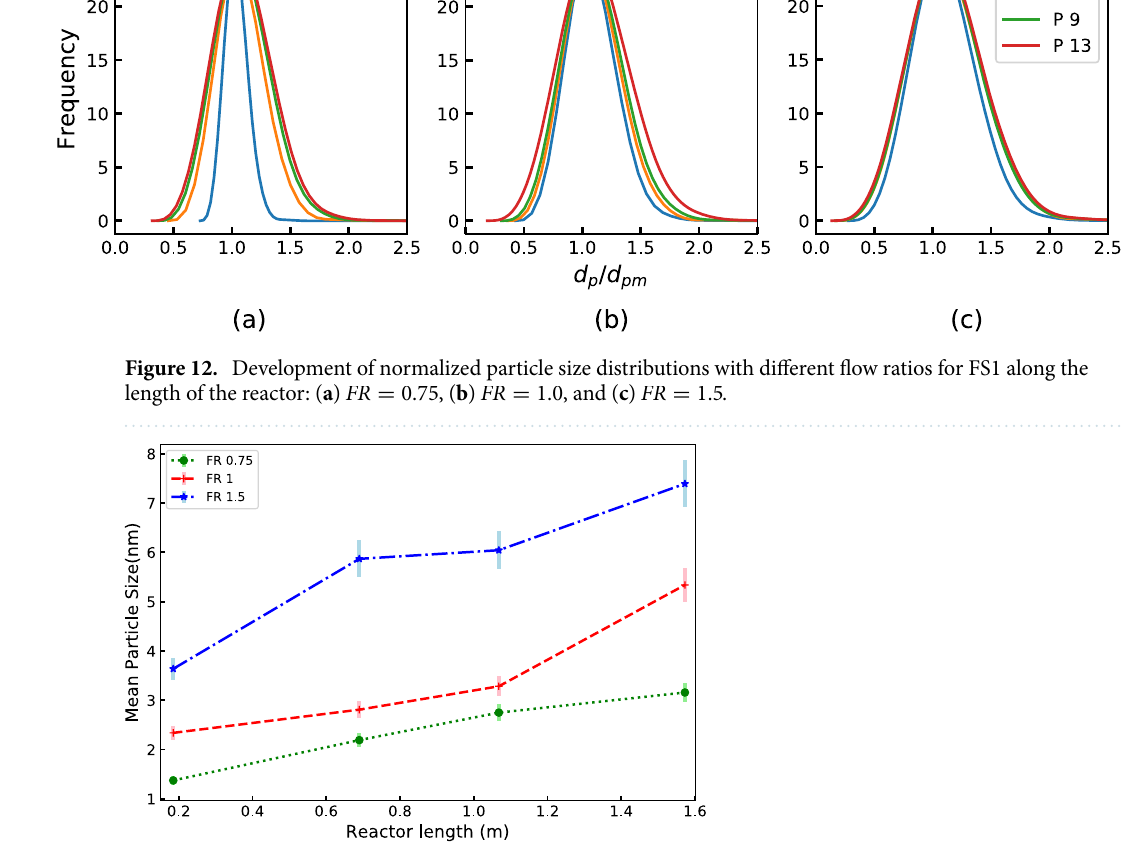
Figure 13. Growth of mean particle size for selected flow ratios with FS1 along the length of the